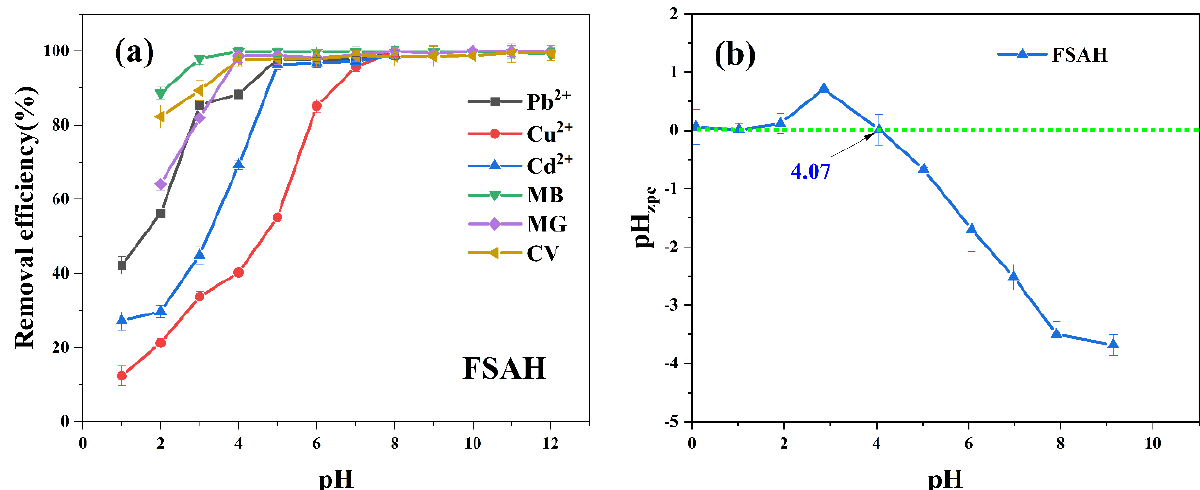
Figure 4. The relationship between pH and heavy metals and dyes removal rate ( a ); the pH ZPC of FSAH ( b ).